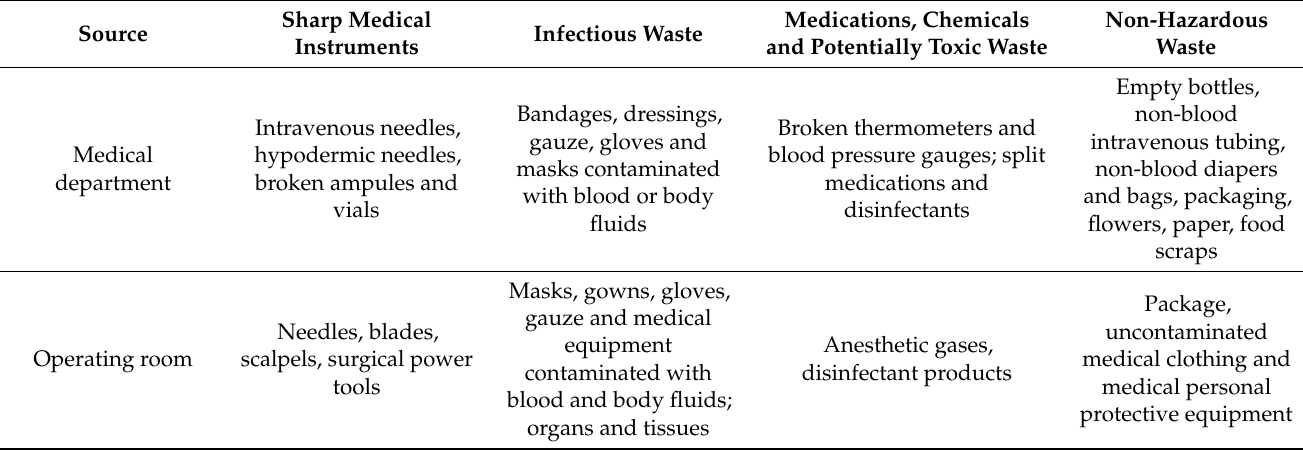
Table 2. Sources and examples of